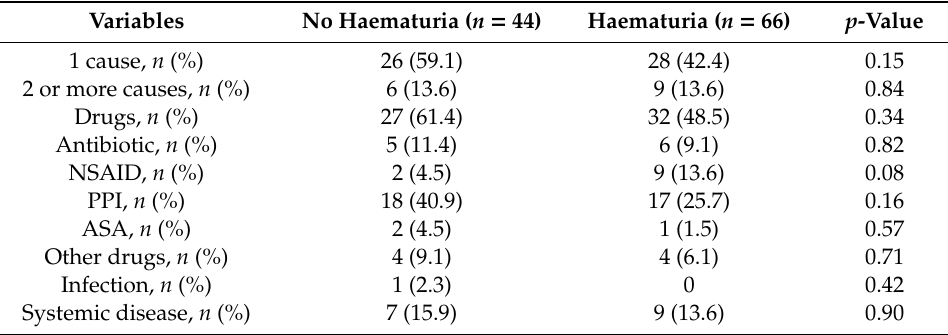
Table 4. Causes of ATIN according to presence of